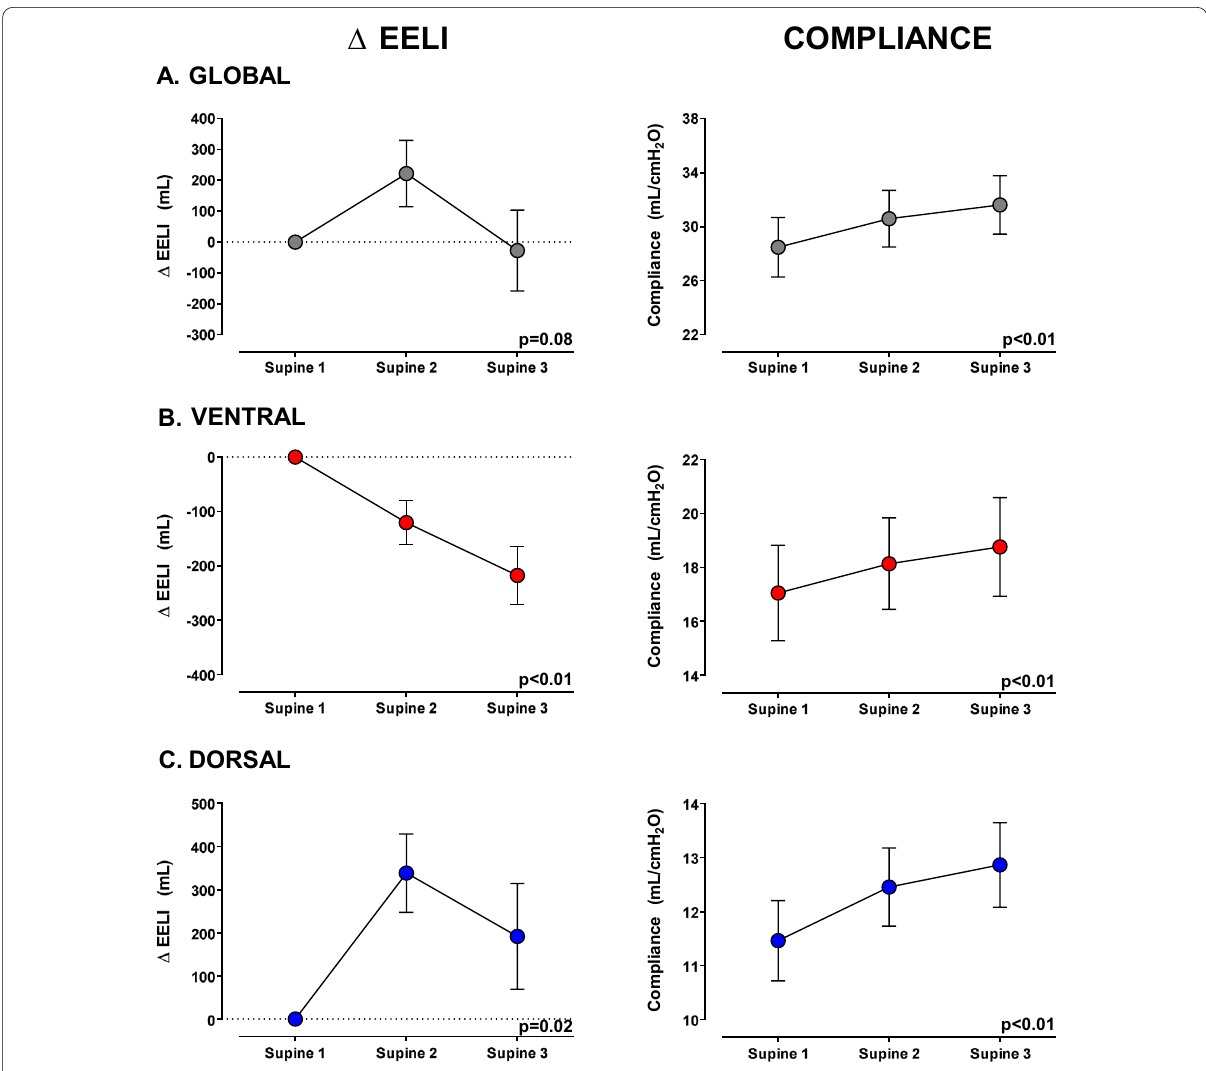
Fig. 2 End‑expiratory lung impedance and compliance changes during supine position steps, from supine‑1 (baseline) to supine‑3 (after second lateral positioning), segmenting the lung into ventral and dorsal areas. The left column shows changes in the EELI, and the right column shows changes in compliance. The figures on the upper panel A show global lung changes, while the figures in the middle panel B show changes in the ventral (anterior half) part of the lung, and the figures on the bottom panel C show changes in the dorsal (posterior half) of the lung. The left column shows that global EELI did not change between supine‑1 and supine‑3, but the EELI decreased in the ventral region and increased in the dorsal region. This redistribution of EELI was accompanied by a progressive increase of the global and regional compliance (both ventral and dorsal) (right column). Δ EELI (mL): end‑expiratory lung impedance change. Data are shown as mean SEM (standard error of mean). Mixed model was ± used for statistical